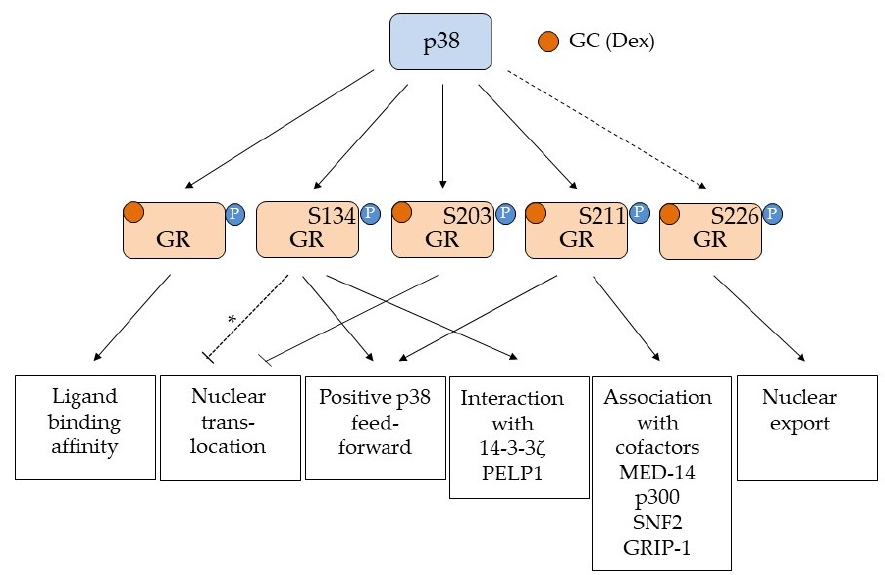
Figure 1. Overview of the GR phosphorylation sites affected by p38 MAPK. Serine (S) 134, 203 and 211 are all phosphorylation sites shown to be affected by p38 MAPK activation. Serine (S) 226 is a JNK phosphorylation site known to enhance nuclear export [36] and is indicated (but not convincingly proven) to be a p38 MAPK phospho site [37–39] (stippled line). The various responses to the individual p38 phosphorylation events are shown in the boxes below. Arrows indicate activation/positive regulation, while a blunted line indicates inhibition. The GR ligand is indicated as GC (glucocorticoid) and Dex (Dexamethasone). For S134, a phosphorylation by AKT1 is reported to prevent nuclear translocation [43], but since this is not proven to be the effect of p38 phosphorylation of this site, it is marked with a stippled line with an asterisk (*). p38-dependent phosphorylation of unspecified residues in GR affects ligand binding [31], while pS134 is shown to be ligand independ-